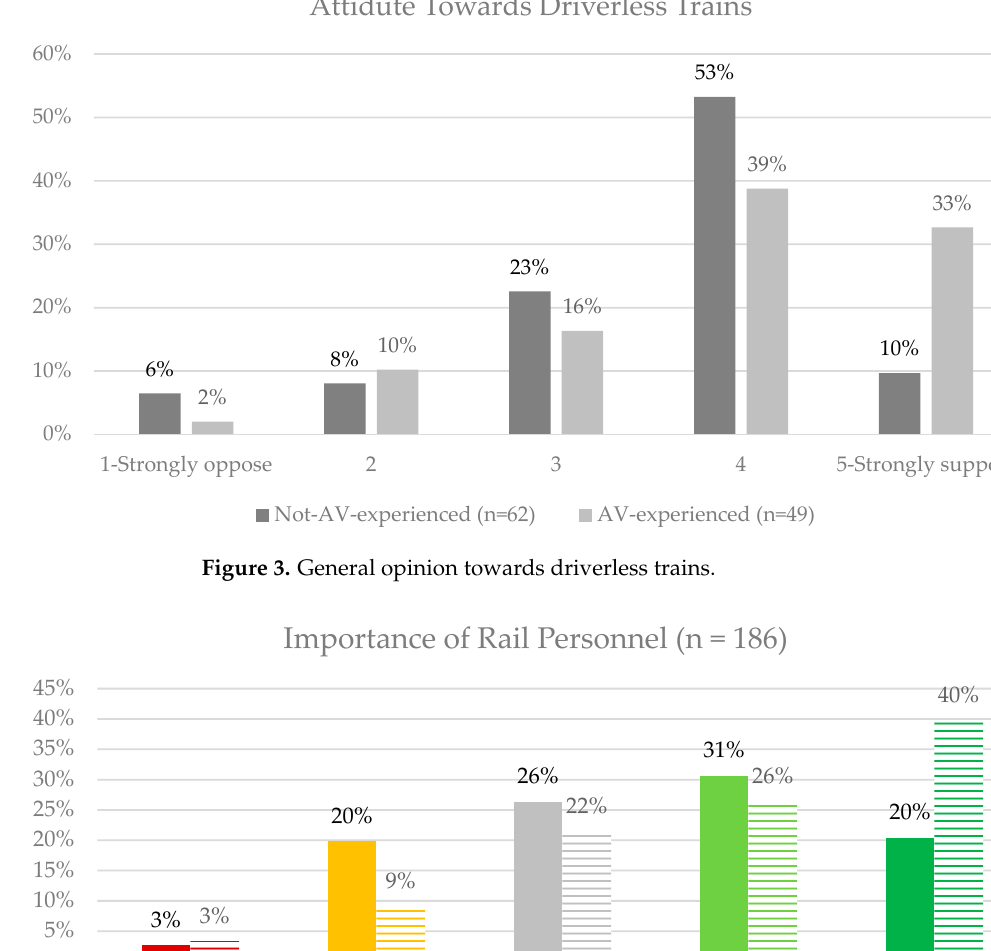
Figure 3. General opinion towards driverless trains.